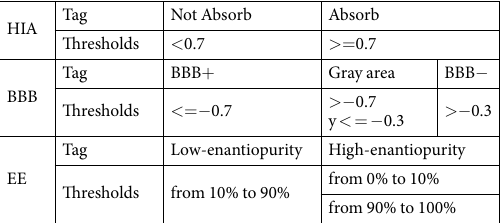
Table 5. Discretization criteria for target properties.